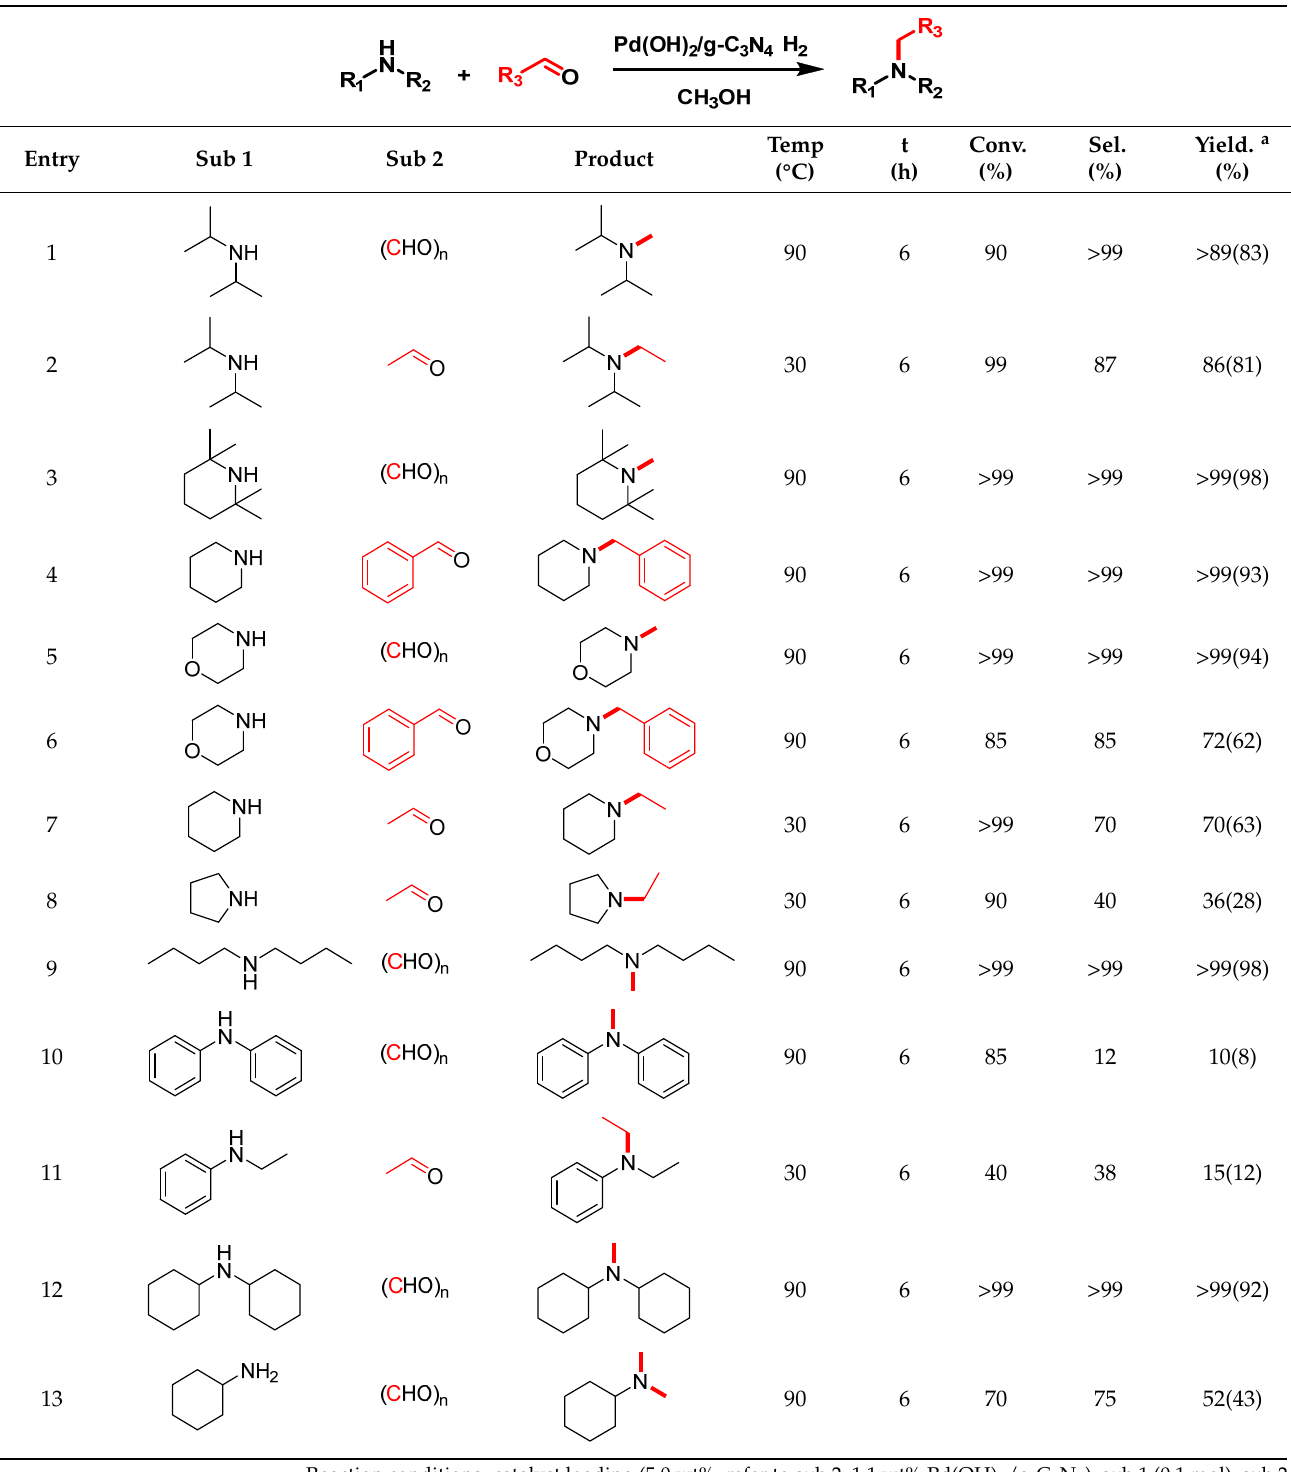
Table 2. Reductive Amination Towards Aldehydes and Amines catalyzed by Pd(OH) 2 /g-C 3 N 4.